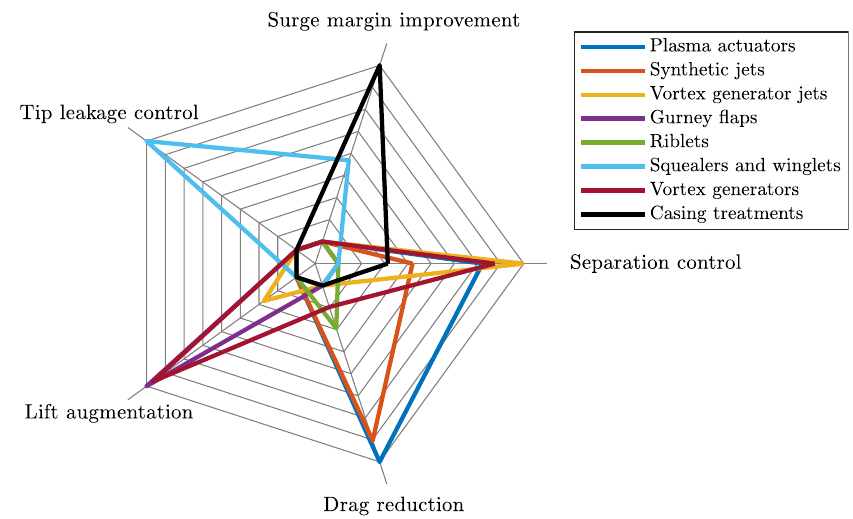
Figure 14. Quantitative presentation of the flow control method